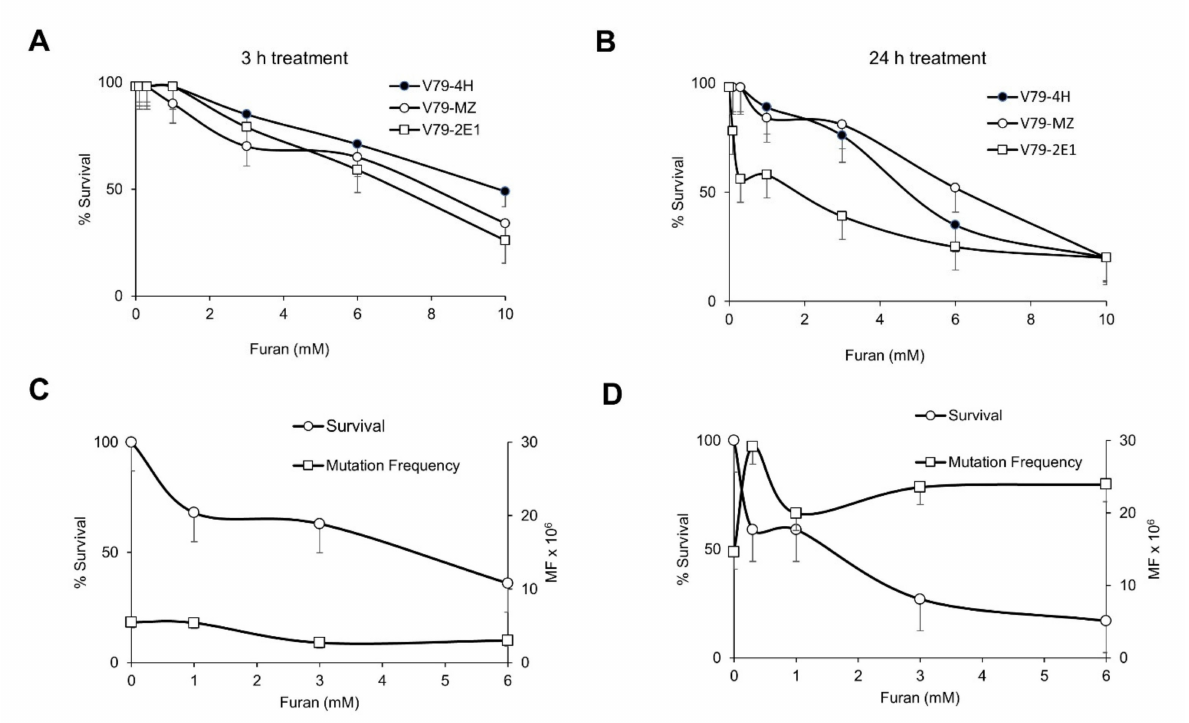
Figure 1. Cytotoxicity and Hprt mutation frequency induced by furan in a panel of V79 cell lines, namely V79-4H, V79-MZ and V79 as detailed in the legend. ( A ) Cytotoxicity after 3 h and ( B ) 24 h exposure at the indicated doses; ( C , D ) cytotoxicity and Hprt mutation frequency after 24 h exposure at the indicated doses in V79-4H ( C ) and V79-2E1 ( D ) cell lines. Furan surviving cells are expressed as percentage of the surviving untreated cells. Mutation frequencies (MF) are calculated as described in M&M. Bars indicate